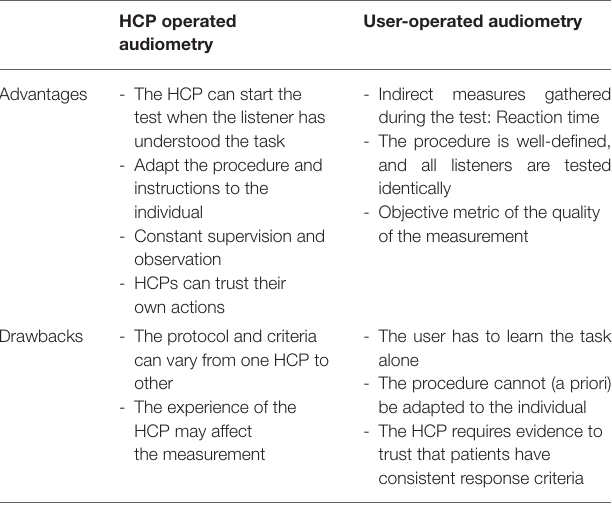
TABLE 1 | Primary examples of the advantages and drawbacks of manually- and user-operated audiometry procedures identified in the UAud